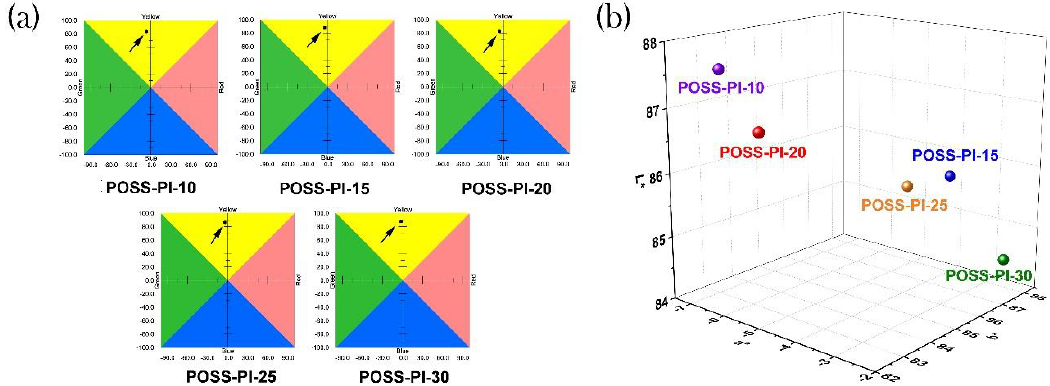
Figure 7. 2D and 3D map for CIE Lab parameters of POSS-PI composite films. ( a ) 2D map; ( b ) 3D map.